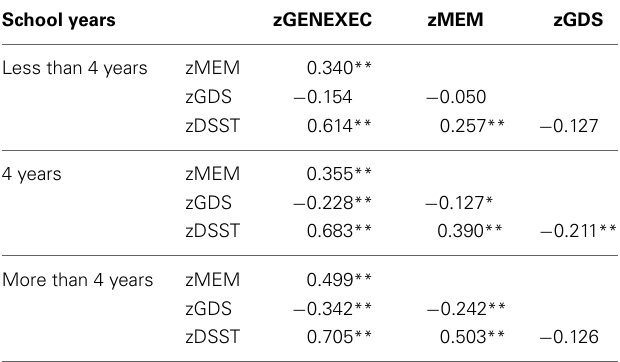
Table 3 | Pearson correlation coefficients for cognition and mood